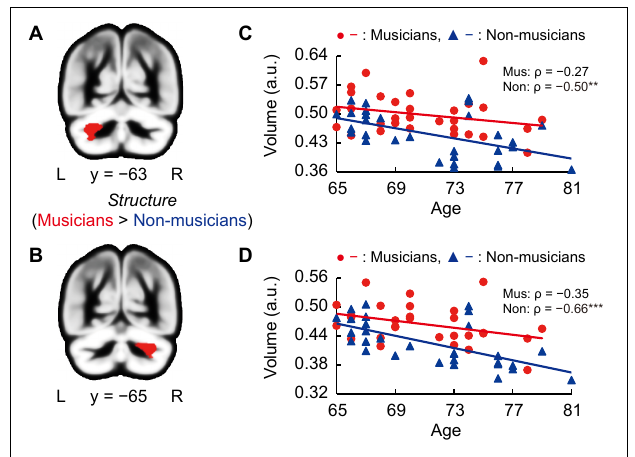
FIGURE 3 | Structural changes related to musical instrument experience. (A,B) Musicians had larger GMVs in both sides of the cerebellum compared to non-musicians. (C,D) For the cerebellar ROIs in both hemispheres, the non-musicians displayed negative correlations between their GMV and age. In musicians, such correlations (age-related volume reductions) were not significant. ** P < 0.01, *** P < 0.001, Mus, musicians; Non, non-musicians;